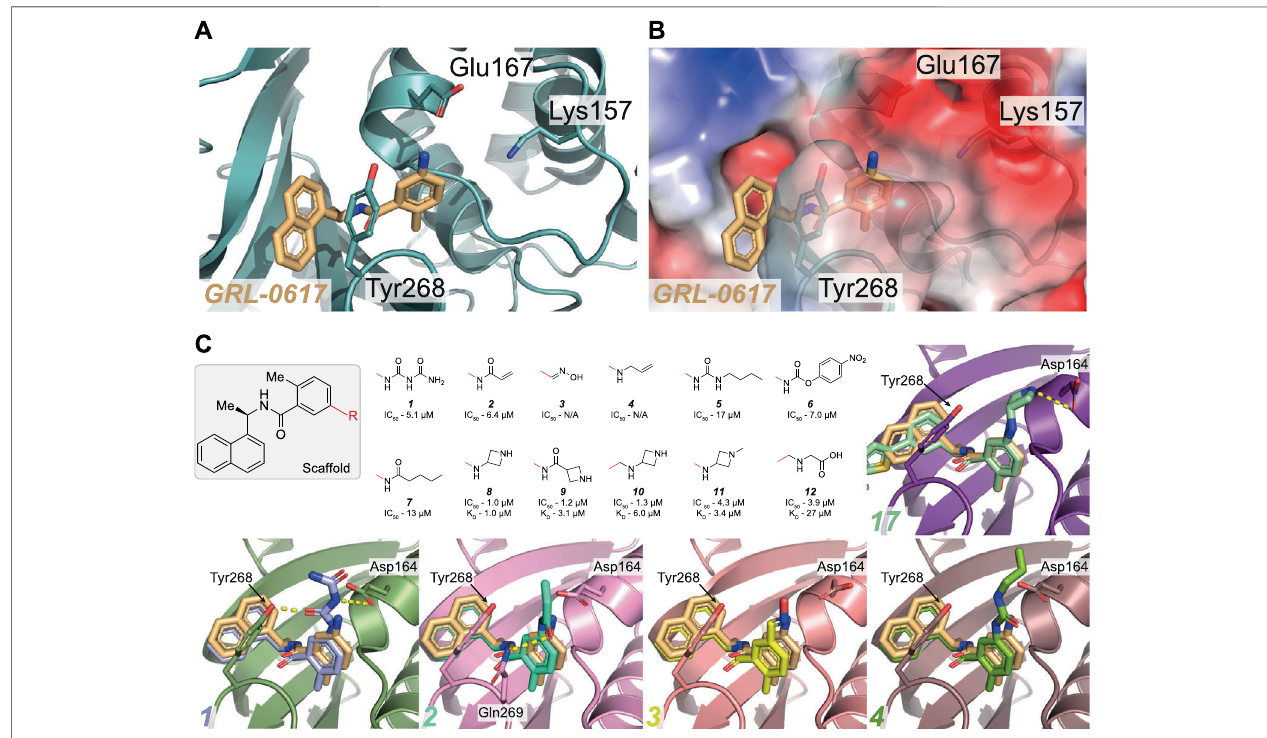
FIGURE 3 | Overview of the reported attempts to target Glu167 in PLpro. (A,B) Close up view of the GRL-0617 binding pocket with PLpro in teal in cartoon representation (A) or as with the calculated surface charge overlaid (B) . The inhibitor is shown in wheat colour in ball-and stick representation. Residues Lys157 to Glu167inthePLproThumbdomainformashallownegativelychargedpocket.SeveralcompoundstargetthesidechainofGlu167toimprovepotencyof GRL-0617 . (C) The GRL-0617 scaffold (boxed) was extended at the para-position of the benzene ring (at the R position). The red line indicates the handle used for the respective substituents - in GRL-0617 an amino group is present at this position. Given compound data refer to, IC 50 from in vitro activity assays, and K D values from SPR where available (See Table 3 for the compound identi fi ers from their respective publications). Basic amines appear to be most tolerated at this position while replacement with alkyl groups are detrimental to activity of the compound. Co-crystal structures for 1 – 4 and 17 ( Figure 4 ) are shown [PDB IDs 1 (7JIT), 2 (7JIW), 3 (7KOL), 4 (7KOJ), 17 (7LBS)]. Compounds 3 and 4 were published in the PDB but excluded from the fi nal publication, so no IC 50 data is available (Osipiuk et al., 2021).